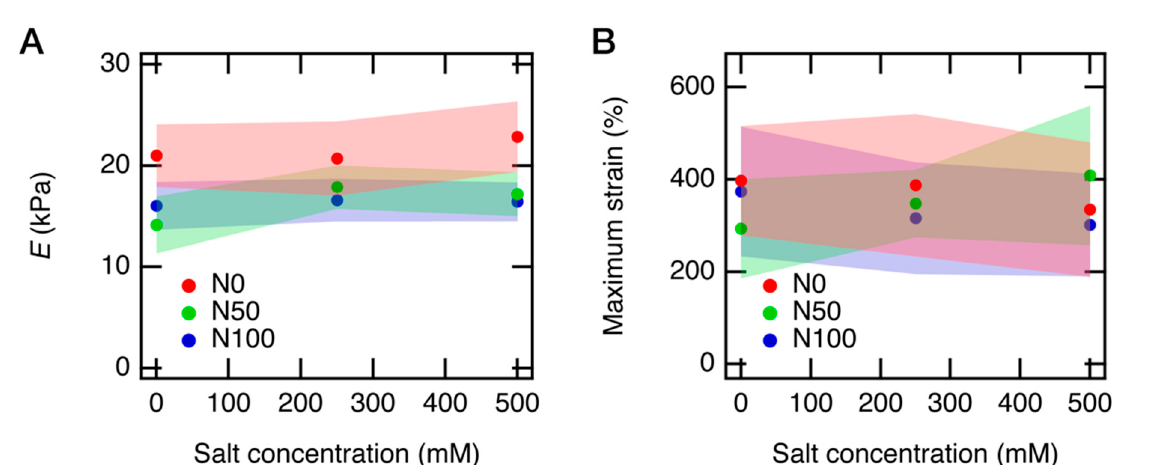
Figure 9. Young’s modulus ( E ) of PAA gels at various neutralization and salt conditions. E is plotted as a function of ( A ) salt concentrations and ( B ) neutralization degrees. The average value and the standard deviation for the Young’s modulus E and the maximum strain are listed in Tables 1 and 2. Table 1. The average value and the standard deviation for the Young’s modulus E of PAA gels at each condition.